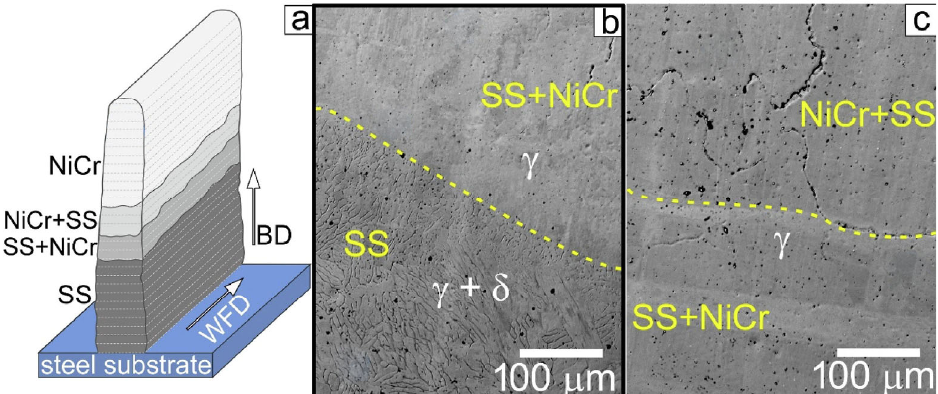
Figure 15. Schematic representation illustrating the appearance of a product with gradient composition obtained by EBAM technology ( a ), the structure of the boundary between the steel and the transition zone ( b ) and between the steel ‐ enriched and nickel ‐ alloyed regions in the transition zone ( c ) [61].